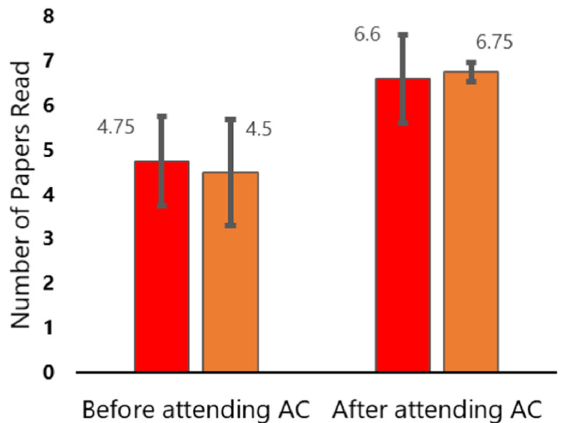
FIG. 2. Average number of papers read by enrollees (red) and volunteers (orange) before and after attending AC for the whole period of the Spring semester 2020 (March 2020 – June 2020). Standard error bars are